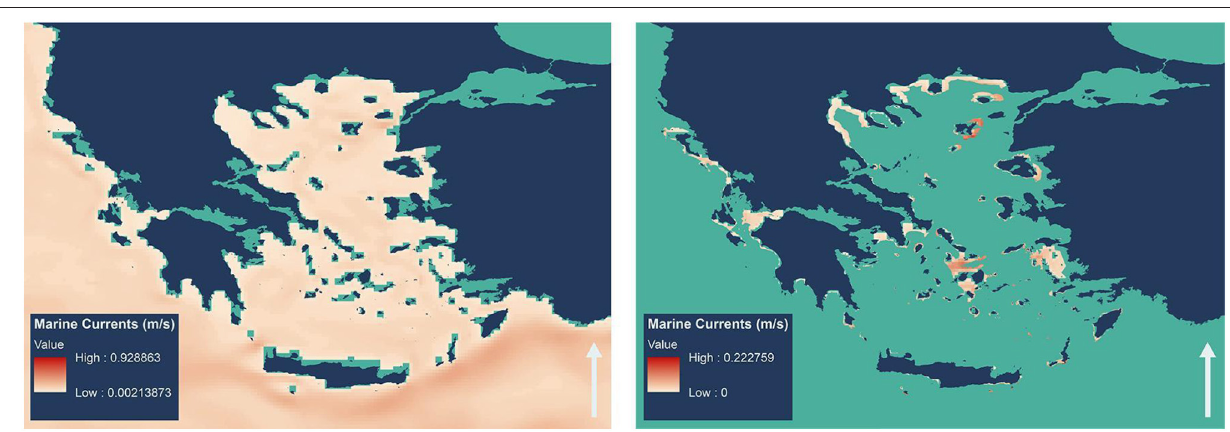
FIGURE 7 | Marine current Energy potential in Greece. (Left) Potential in the whole Greek territory. (Right) Areas of exploitable potential focused on sites with proper bathymetry, out of nature protected areas and within greek territory sea (Maestrale WEBGIS,